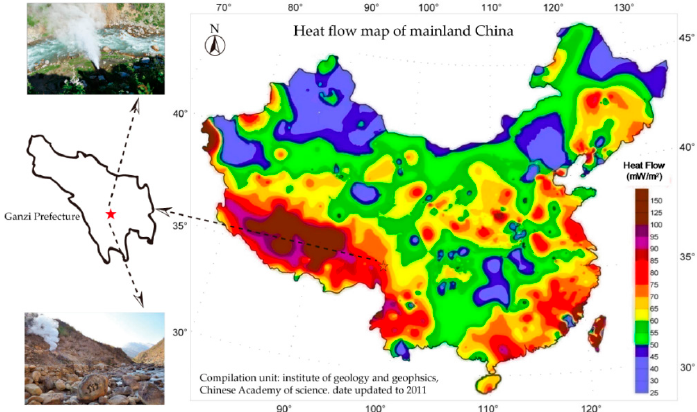
Figure 1. Location of the monzonitic quarry near the Ganzi geothermal well .